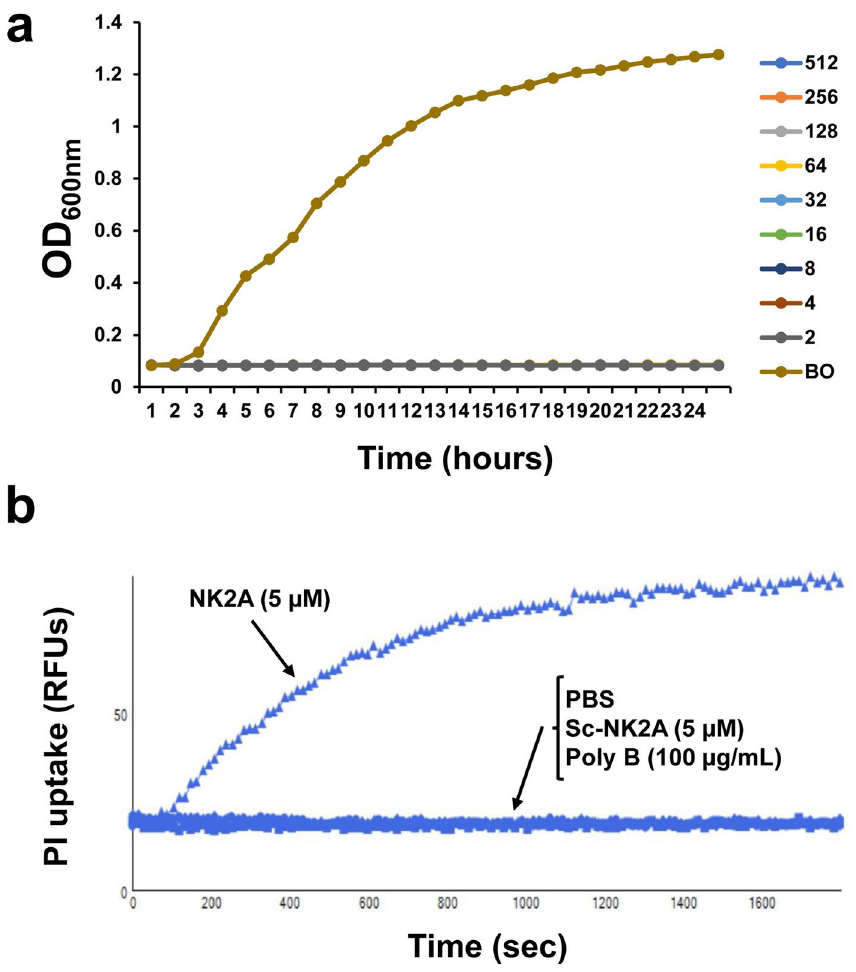
Figure 5. Assessment of propidium iodide (PI) uptake by Salmonella incubated with NK2A, Sc-NK2A and polymyxin B. ( a ) Growth curve graphs (OD 600nm ) were generated using an automated growth curve reader for Salmonella outbreak isolate SX238 after incubation with different concentrations of polymyxin B (0–512 μg/ mL). One representative graph out of three independent experiments is shown. ( b ) Salmonella (SX238) was preincubated with PI followed by the addition of NK2A, Sc-NK2A (5 μM final concentration) or polymyxin B (100 μg/mL concentration), and PI signal was measured by a fluorescent microplate reader using flex mode with 15 s intervals for up to 30 min. PI uptake signals are shown as relative fluorescent units (RFUs). Bacteria incubated with PBS was used as a negative control. One representative PI uptake graph out of three independent experiments is